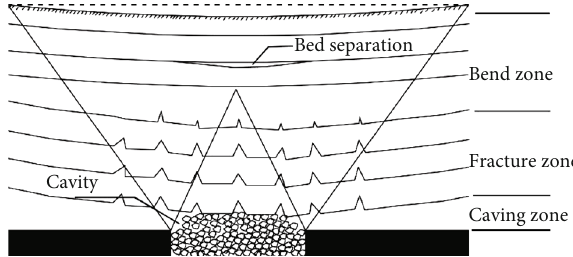
Figure 1: Damaged structure model of the overlying rock in the old goaf of the long